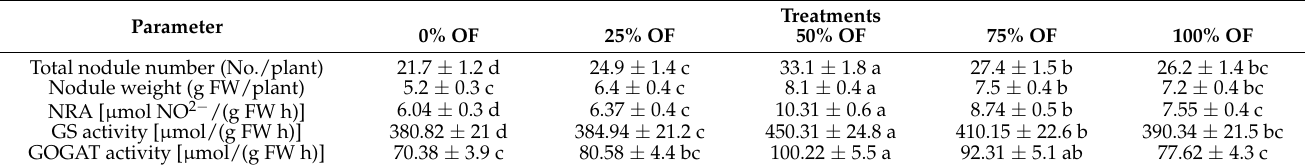
Table 9. Effects of organic and inorganic fertilizer on total nodule number, nodule weight, NR activity, GS activity and GOGAT activity at 170 DAT